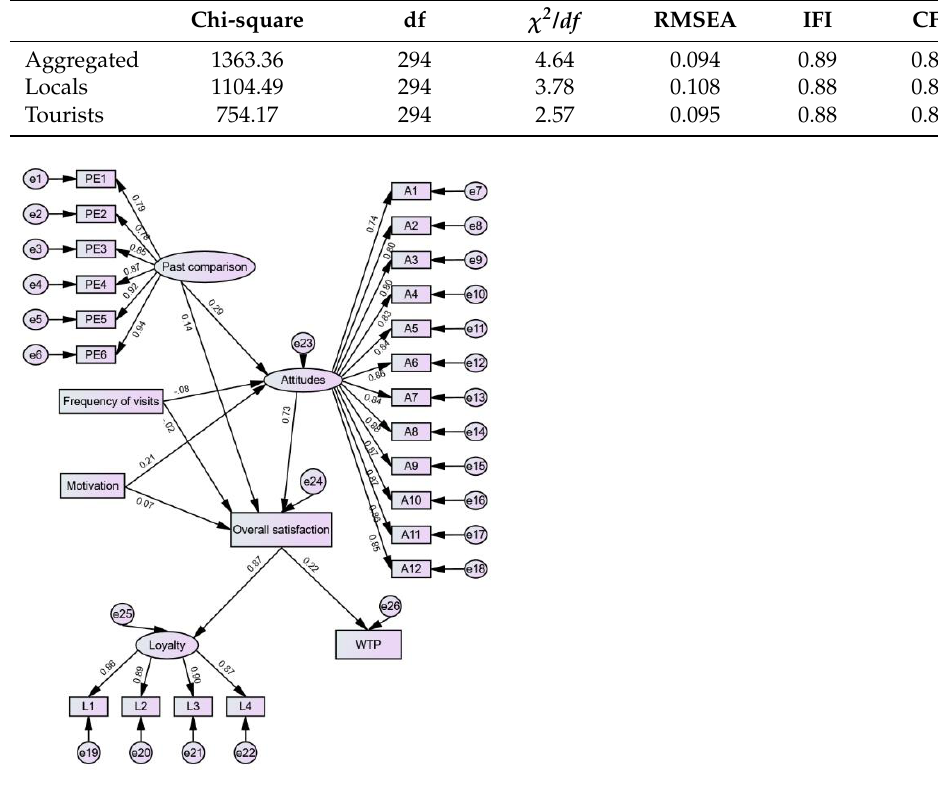
Figure 7. SEM for locals and tourists combined.